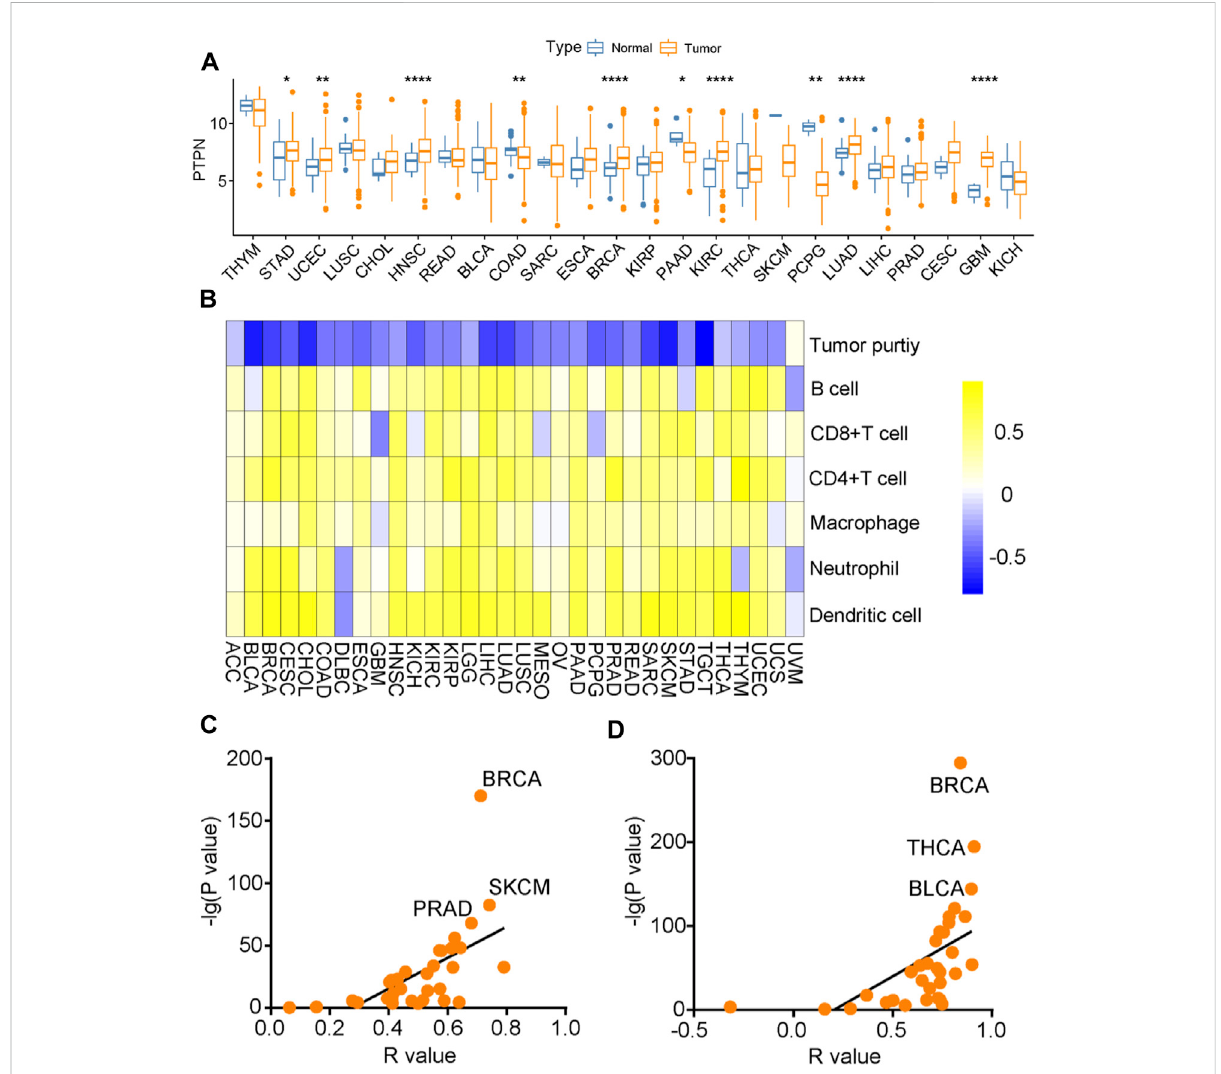
FIGURE 6 Immuno-correlation of PTPN7 in pan-cancer. (A) Expression of PTPN7 in pan-cancer. (B) Correlations between PTPN7 and 6 TIICs calculated withtheTIMERalgorithm.Thecolorindicatesthecorrelationcoef fi cient. (C,D) ThecorrelationbetweenPTPN7andPD-L1&CTLA-4invarioustumor